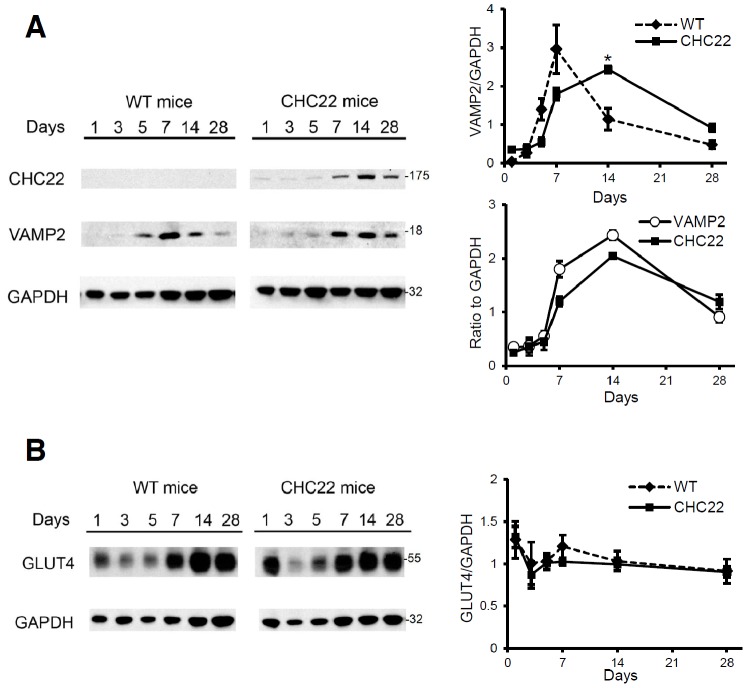
Elevation of components of the GLUT4 trafficking pathway during mouse skeletal muscle regeneration.A) VAMP2 and CHC22 levels during muscle regeneration after cardiotoxin injection on day 0 were compared between WT and CHC22-mice in muscle samples harvested on the day indicated. One typical set of immunoblots is shown at the left and quantification of VAMP2 relative to GAPDH signals from three experiments generated the ratios plotted at the right (upper plot). There was a statistically significant difference between WT and CHC22-mice in VAMP2 expression on day 14 after cardiotoxin injection (*p<0.05), as determined by Student’s t test. Quantification of VAMP2 and CHC22 relative to GAPDH in the CHC22-mice shown at the left was plotted (right, bottom). B) GLUT4 levels during muscle regeneration for wild type and CHC22-mice (n = 3). One typical set of immunoblots is shown at the left and quantification of GLUT4 relative to GAPDH signals is plotted on the right. No significant difference between WT and CHC22-mice was detected. Molecular mass (kilodaltons) of the proteins detected is indicated at the right.